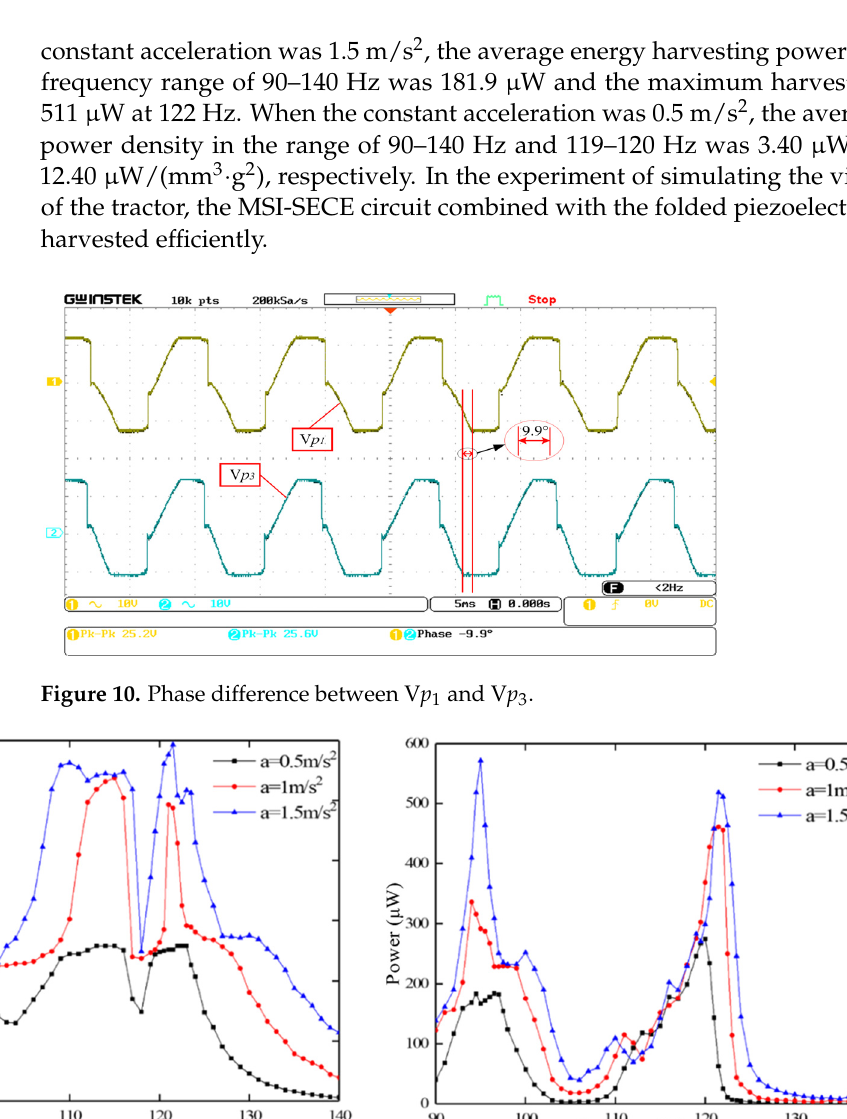
Figure 11. The sweep power output of the MSI-SECE circuit.